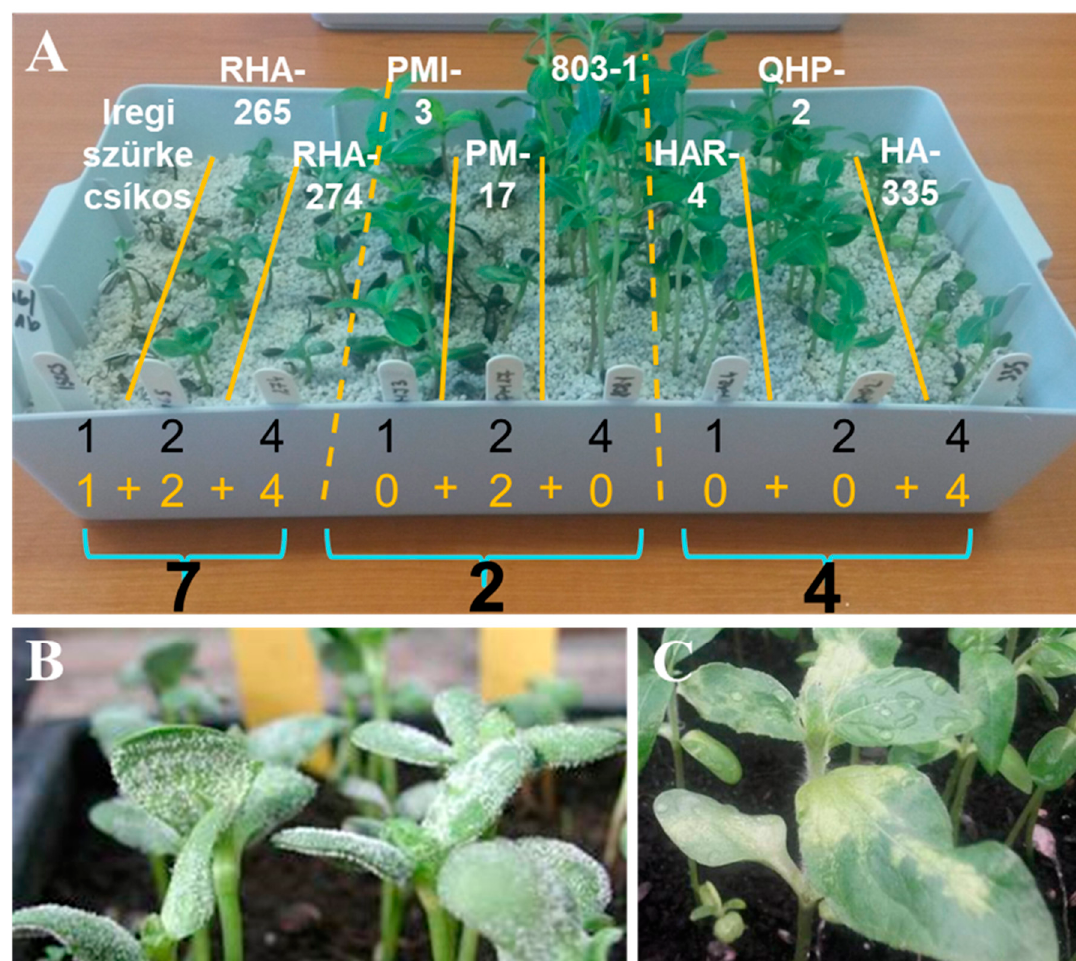
Figure 1. The pathotyping process of Plasmopara halstedii (photo: R. Bán). ( A ) The differential sunflower set. Except for the first line, each possesses specific resistance genes against P. halstedii . Differential lines are grouped into three sets of three lines. If the sunflower line is susceptible, a value of 1, 2, and 4 is assigned to the first, second, and third lines within each group, respectively. In the case of resistant reaction, the value is 0. The values are added within each group, which results in a three-digit code (coded virulence formula, CVF). The identification of pathotype 724 is shown as an example. ( B ) Signs of P. halstedii on the cotyledons. The disease was first assessed based on the formation of white sporulation. ( C ) Symptoms of P. halstedii on the true leaves. A second evaluation was made 21 days after inoculation based on the appearance of white coating and chlorotic lesions on true leaves and stunting of plants. Differential lines were assessed as susceptible if sporulation occurred on the cotyledons and/or chlorosis appeared along the veins of the true leaves.